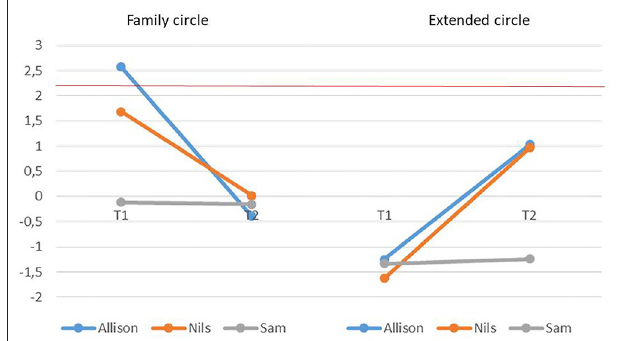
FIGURE 3 | Narratives associated with family circle (left) and extended circle (right) produced during the first (T1) and second (T2) assessments. The red line represents the pathological cut-off score ( z = 2.179).